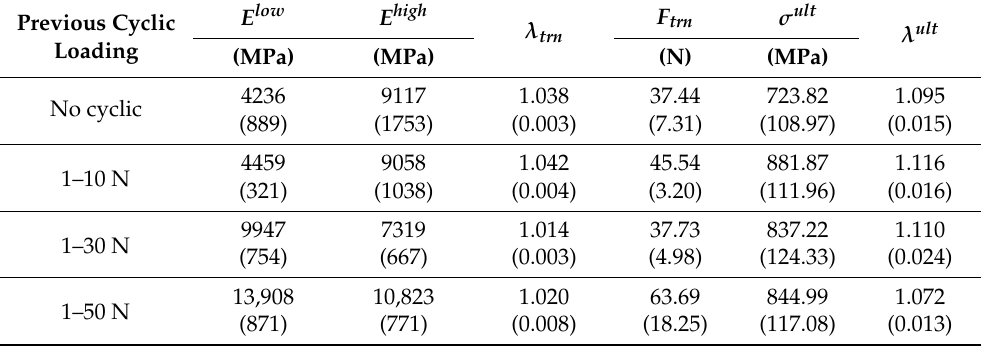
Table 3. Parameters of the bilinear model fits the data of load-to-failure tests performed at 1 mm/s with no previous cyclic loading and after 10 loading cycles at 1–10 N, 1–30 N, and 1–50 N. Values are given as mean (SD).